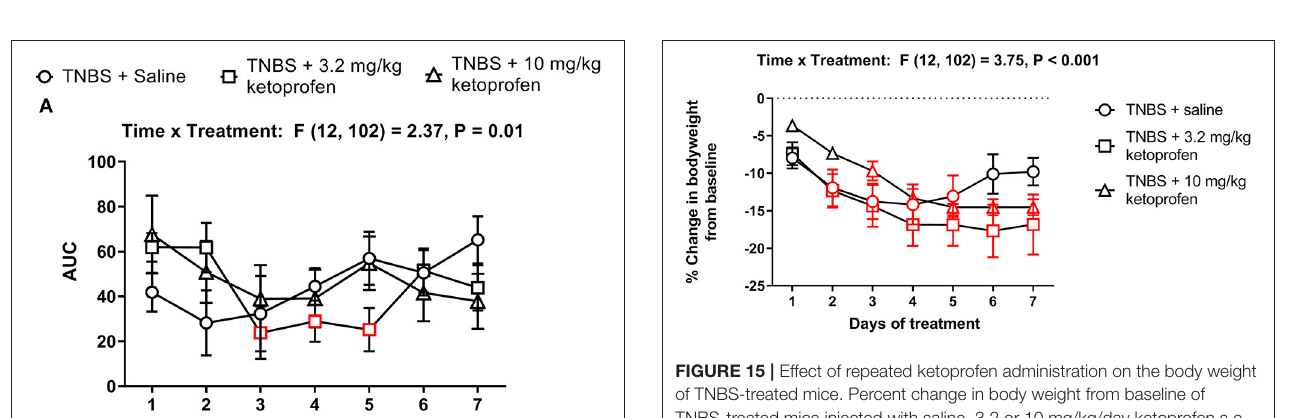
FIGURE 13 | significantly alter nesting in TNBS-treated mice, except on Day 2, 3.2 mg/kg ketoprofen significantly mitigated TNBS-induced depressed nesting. Data are mean ± SEM. TNBS + saline ( N = 8/day); TNBS + 3.2 mg/kg ketoprofen ( N = 7/day); TNBS + 10 mg/kg ketoprofen ( N = 5/day). Data are analyzed by two-way repeated measures ANOVA with Bonferroni’s post-test .